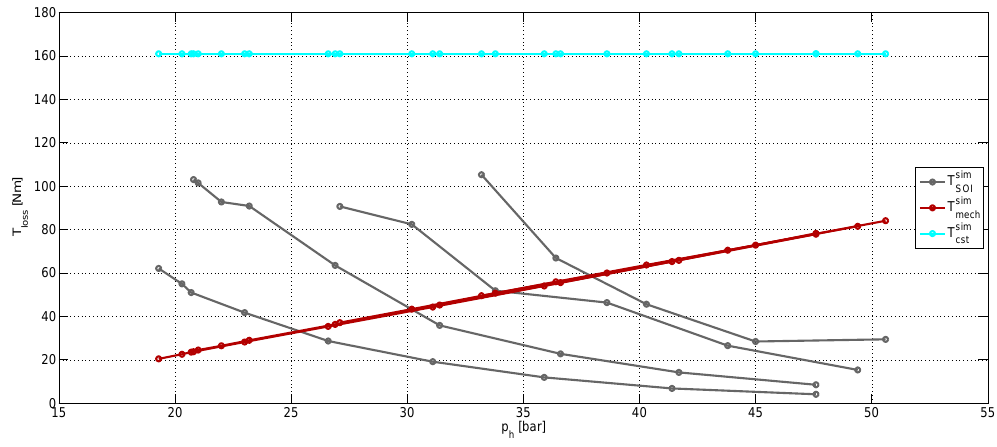
Figure 12: The individual simulated torque losses based on eq. (16) and after parameter